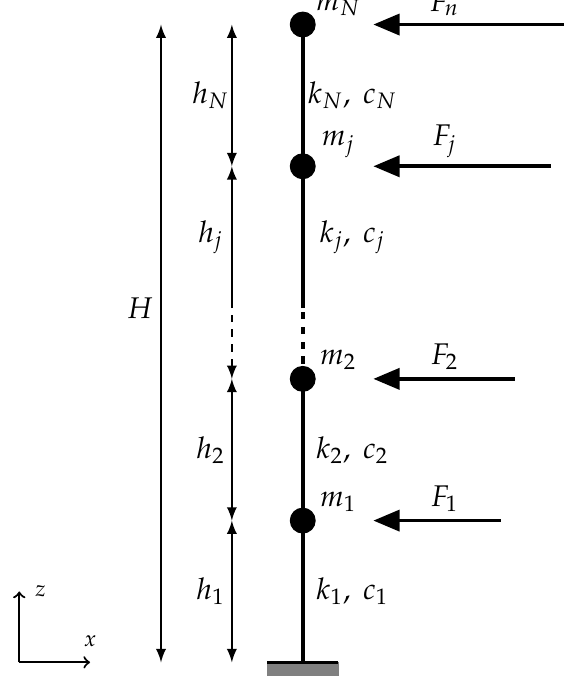
Figure 1. General model that represents an N -storeys structure with its fundamental parameters.